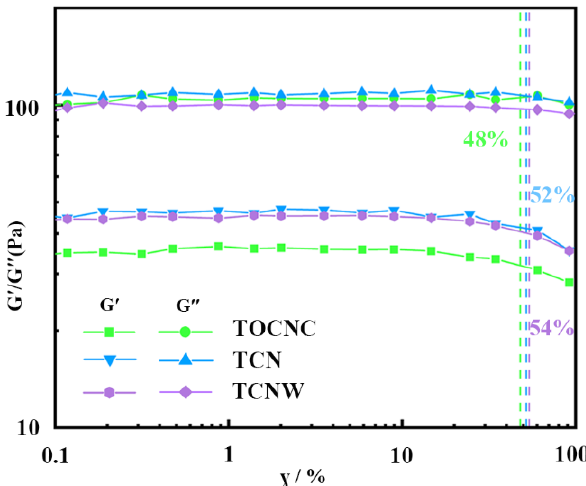
(cid:48) ) and loss moduli (G”) of